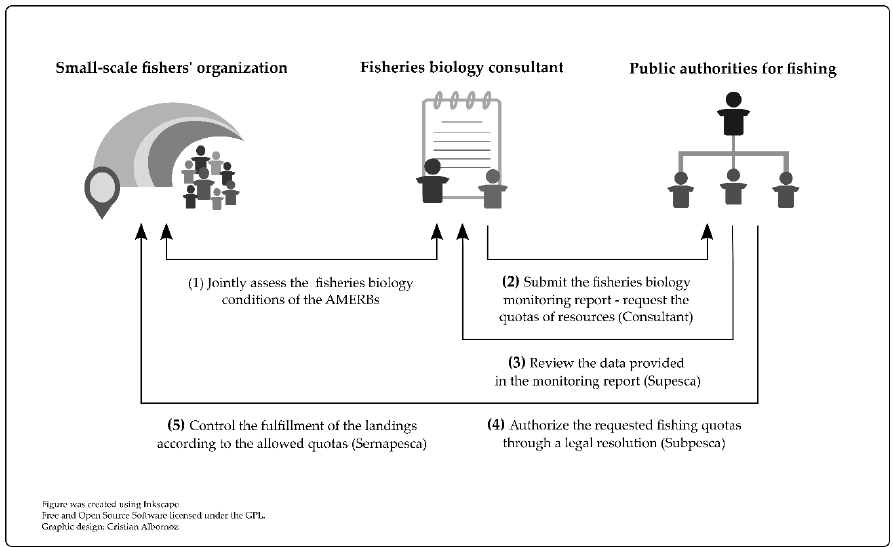
Figure 1. Simplified scheme of formal processes in the management and exploitation areas for benthic resources (AMERB) co-management system.